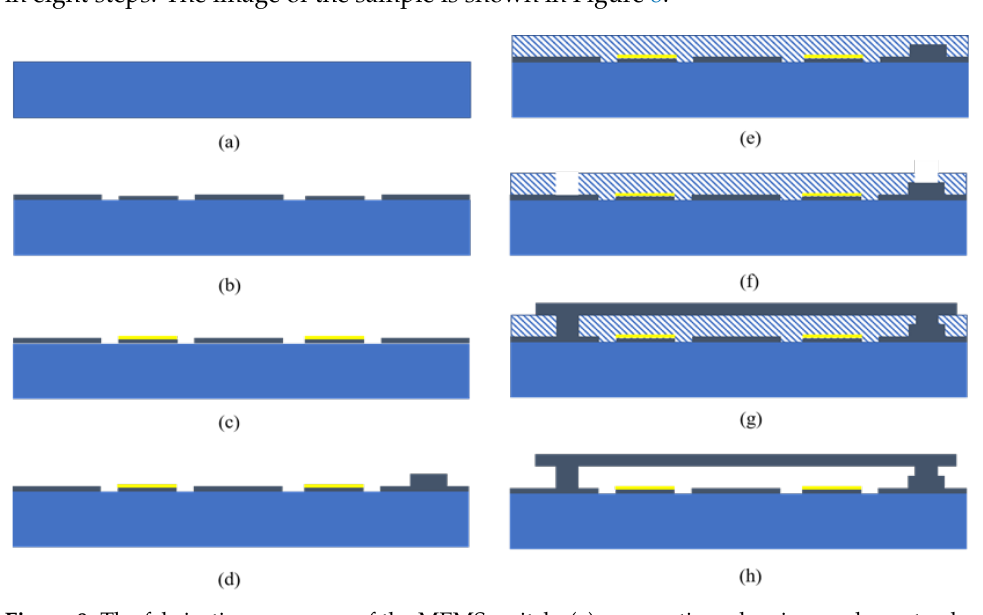
Figure 8. The fabrication processes of the MEMS switch: ( a ) preparation, cleaning, and quartz glass substrate cleaning; ( b ) the fabrication of CPW; ( c ) the fabrication of dielectric layer; ( d ) the fabrication of resonant ring; ( e ) sacrificial layer preparation; ( f ) making anchor through holes; ( g ) the fabrication of top electrode; ( h ) sacrifice layer release.